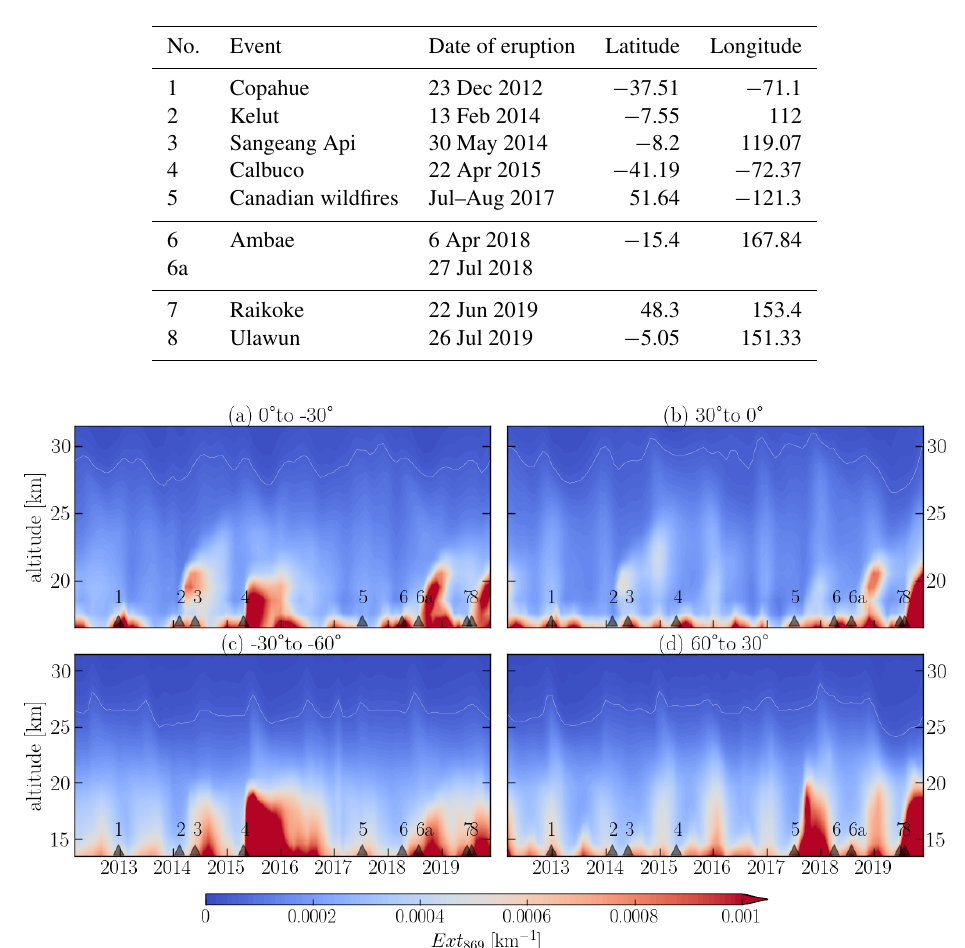
Figure 3. Monthly mean aerosol extinction coefficient ( Ext 869 ) distribution as a function of time and altitude. The values were obtained by binning and zonally averaging OMPS-LP monthly level 3 Ext 869 . The white lines show 0.00005km − 1 Ext 869 level. The triangles with numbers represent volcanic eruptions and biomass burning events (see Table